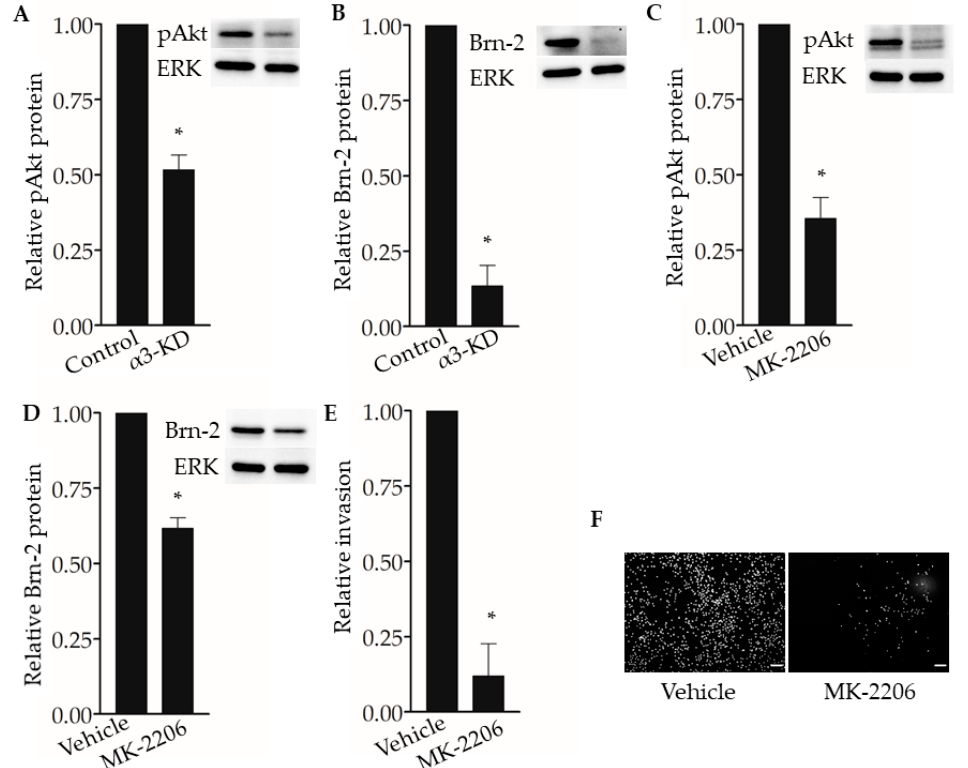
Figure 8. Integrin α 3 β 1-dependent Akt phosphorylation influences Brn-2 expression and invasion of MDA-MB-231 cells. ( A , B ) Representative Western blots and corresponding graphs show relative levels of ( A ) phospho-Akt (pAkt) and ( B ) Brn-2 in α 3-KD cells relative to control. ( C , D ) Representative Western blots and corresponding graphs show relative levels of ( C ) pAkt and ( D ) Brn-2 in cells treated with DMSO (vehicle) or pAkt inhibitor (MK-2206). ( E ) Graph shows the relative invasion of MK-2206-treated cells compared to vehicle-treated cells. ( F ) Representative images for data in ( E ). n = 3 experiments; mean +/ − SEM; * p < 0.05; two-tailed T -test; scale bar, 100 µm.